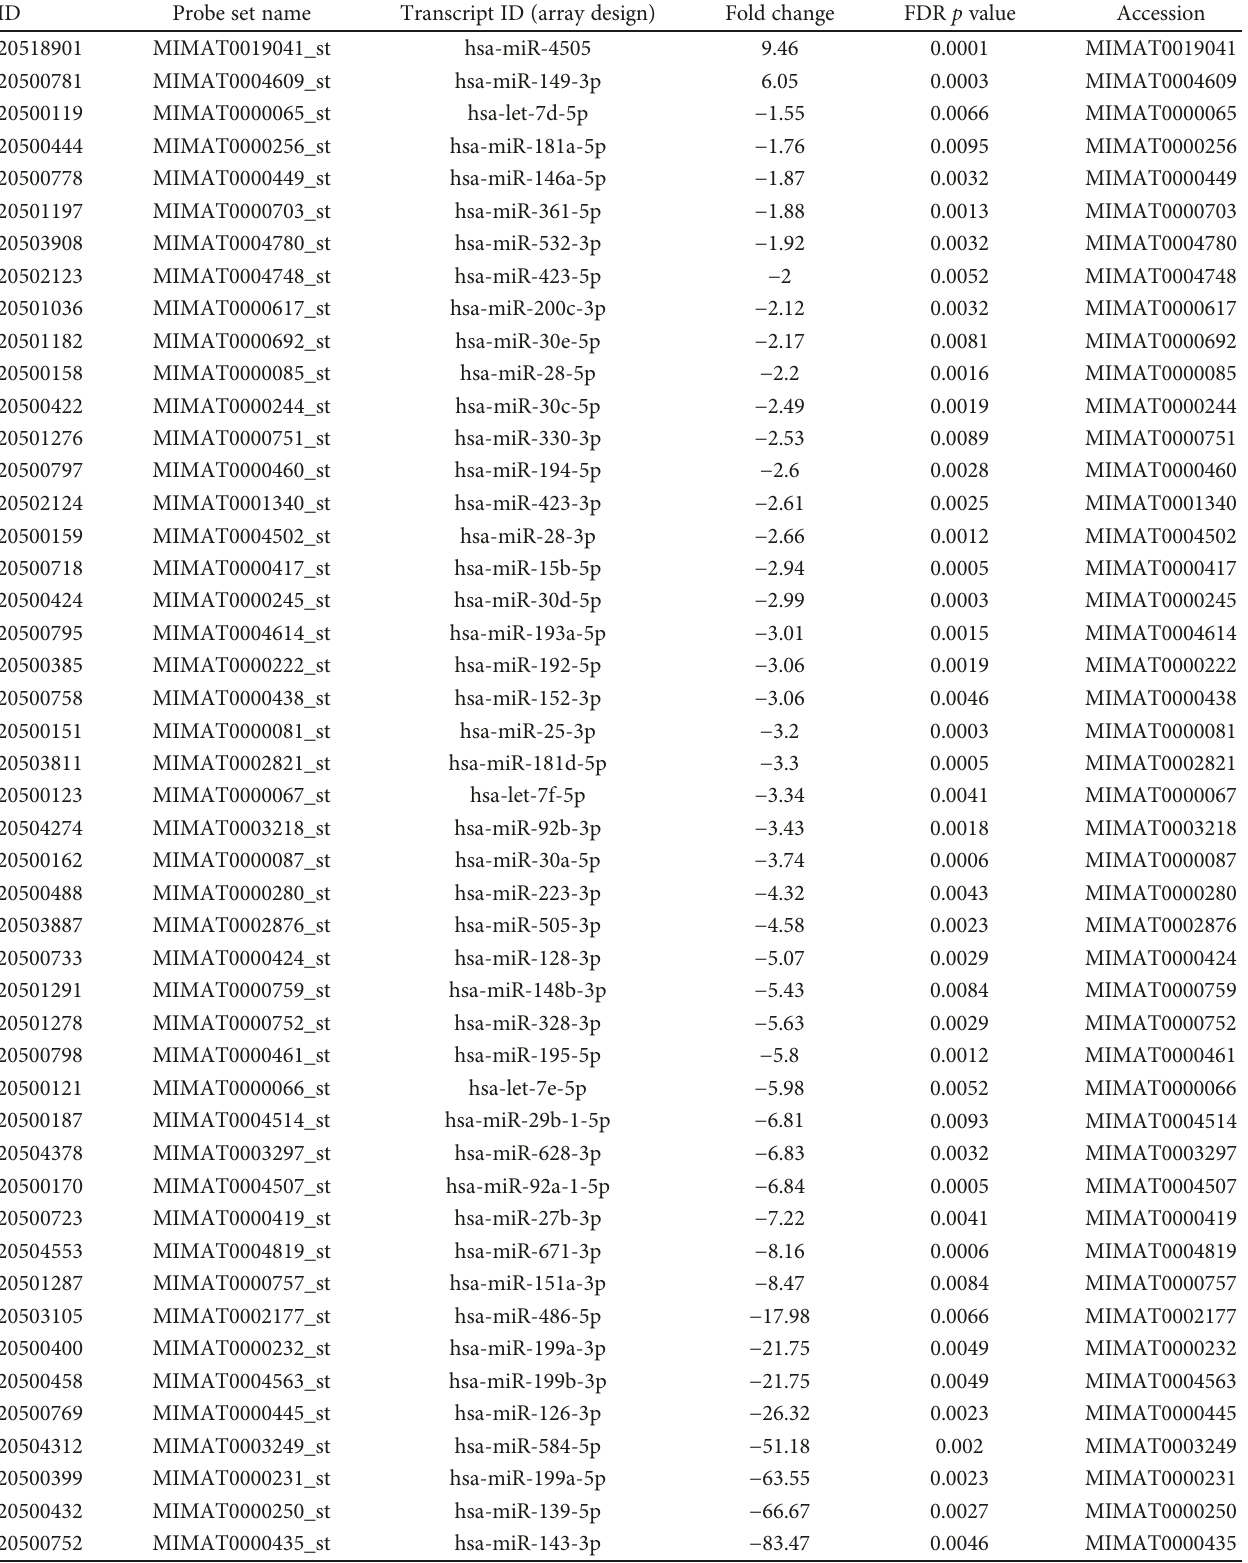
Table 2: miRNAs modulated in BD patients versus healthy